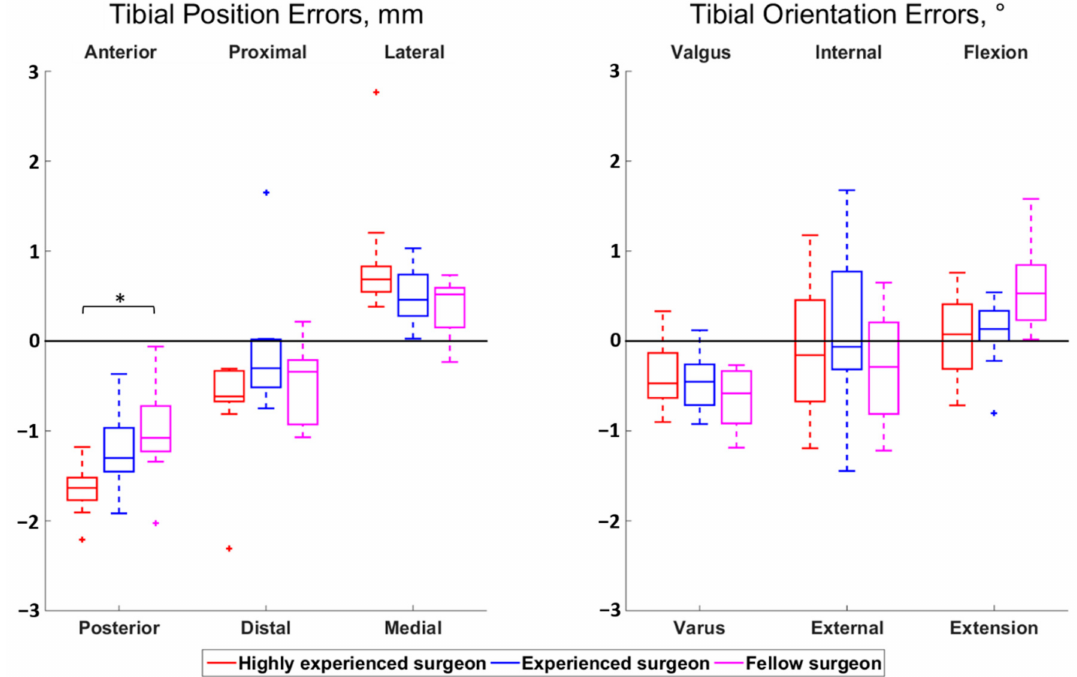
Figure 3. Boxplot of the position ( left ) and orientation ( right ) errors for the tibial cut. The direction at the top and bottom of the plots indicate where the actual cuts were compared to the planned cuts. For example, a positive anterior–posterior error indicates a cut that was too anterior compared to the planning. Statistically significant differences among surgeons are asterisked ( p <